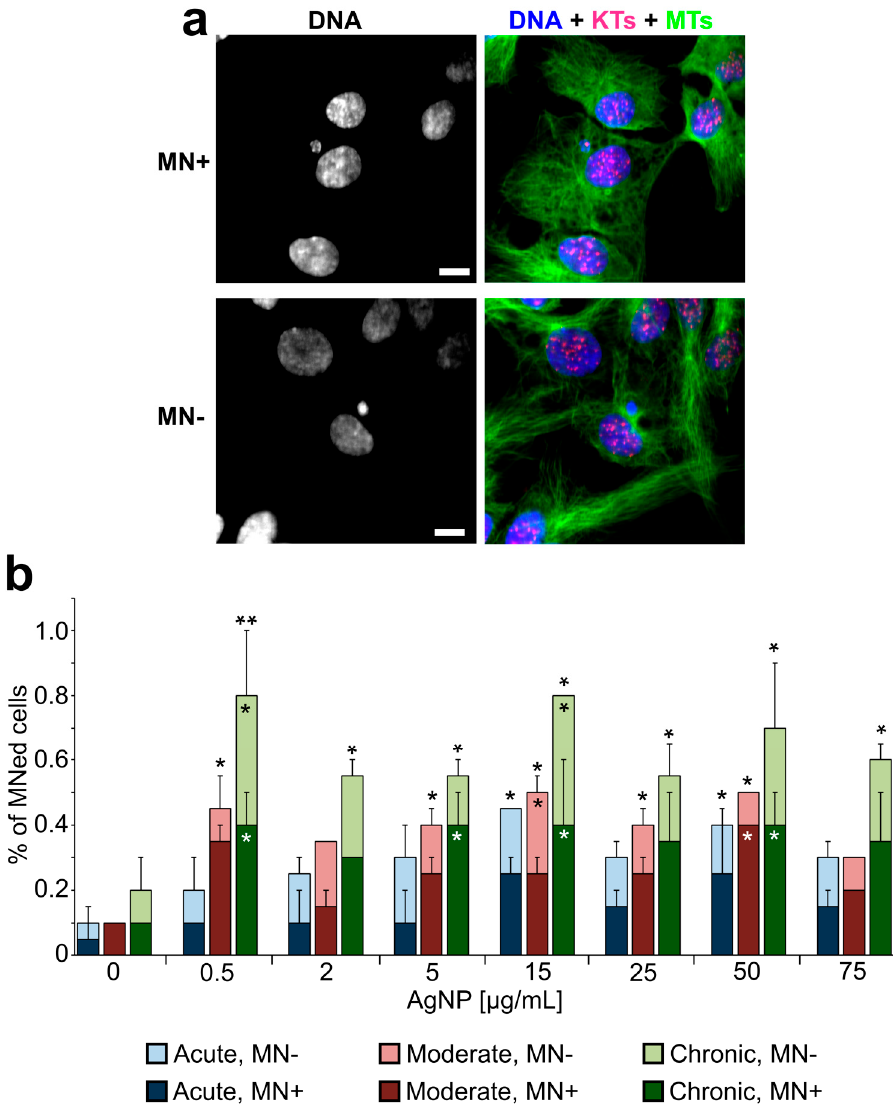
Figure 7. Increased frequencies of micronuclei in AgNP-treated cell populations. ( a ) Example fluorescence images with DNA staining (shown alone in the left panel and in blue in the right panel) and immunostaining for microtubules (MTs, green in the right panel) and kinetochore proteins (KTs, red / pink in the right panel). The two images represent examples of a kinetochore positive micronucleus (MN + , top; note red / pink kinetochore dot within the micronucleus) and a kinetochore negative micronucleus (MN-, bottom). Scale bars, 5 µ m. ( b ) Percentage of cells with micronuclei (MN + dark bars, MN- light bars) at the end of acute, moderate, or chronic exposure to AgNPs. *Fisher’s exact test, p < 0.05; **Fisher’s exact test, p < 0.005. The asterisks above the bars refer to comparisons for total number of micronucleated cells in treated samples vs. corresponding untreated control. The asterisks overlaid to individual bars refer to comparisons for a specific class of micronuclei (MN + , dark bars; MN- light bars) in treated samples vs. corresponding untreated control.